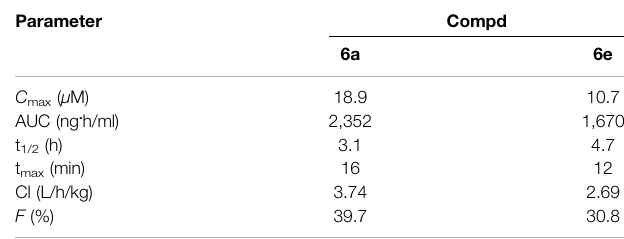
TABLE 3 | In vitro stability of hybrids 6a,e . TABLE 4 | Pharmacokinetic properties of hybrids 6a,e in